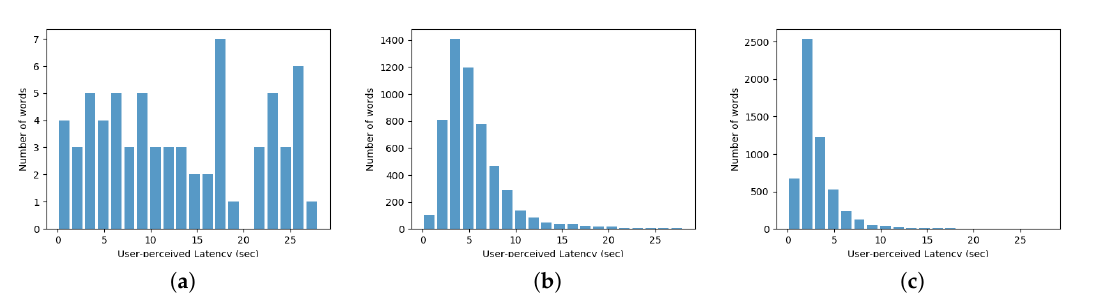
Figure 8. Histogram of the user-perceived latency for all words in test set 1. ( a ) Without VAD ( b ) WithVAD, minibatch 200 ( c ) WithVAD, minibatch